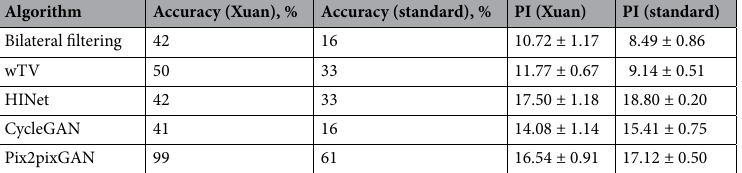
Table 2. The accuracy of character recognition and PI scores in denoised THz images with different algorithms.